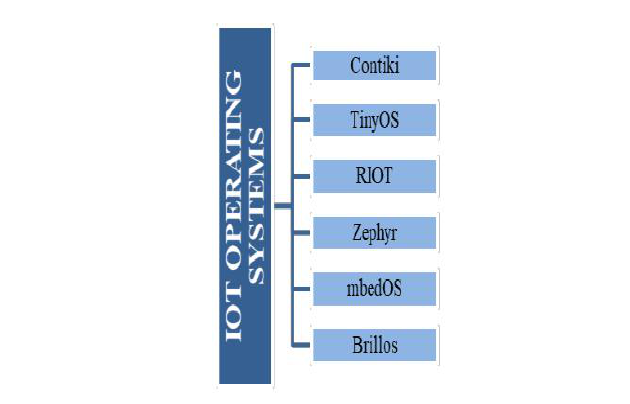
Figure 1. Layout of Different Operating